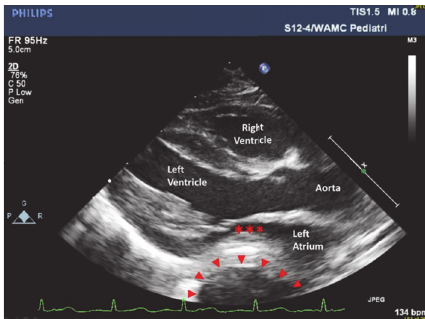
Figure 2: Parasternal long axis showing anterior deviation of the left atrium with anatomical impingement of the mitral valve annulus ( ∗ ) by the stomach (arrowhead).